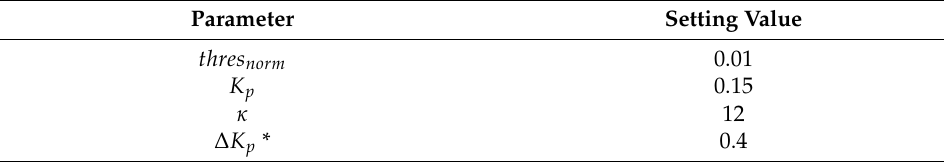
Table 3. Parameter setting for the proposed online adaptive K p tuning algorithm. Parameter